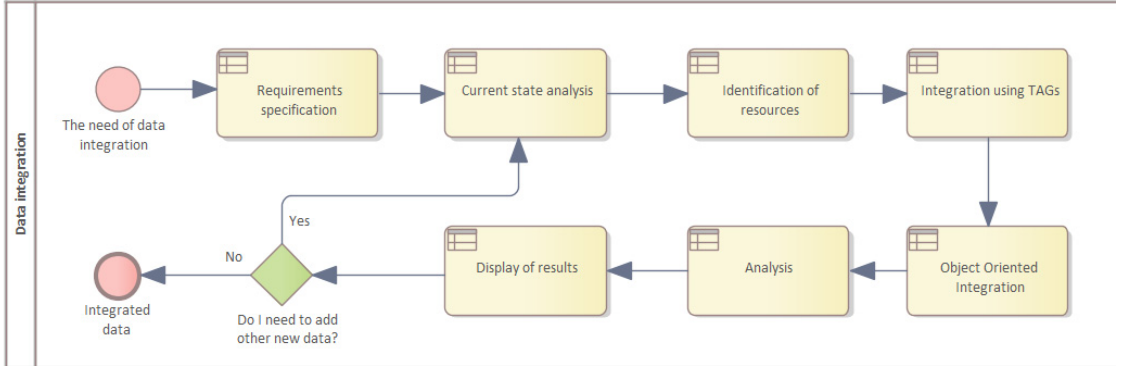
Figure 4. Data integration